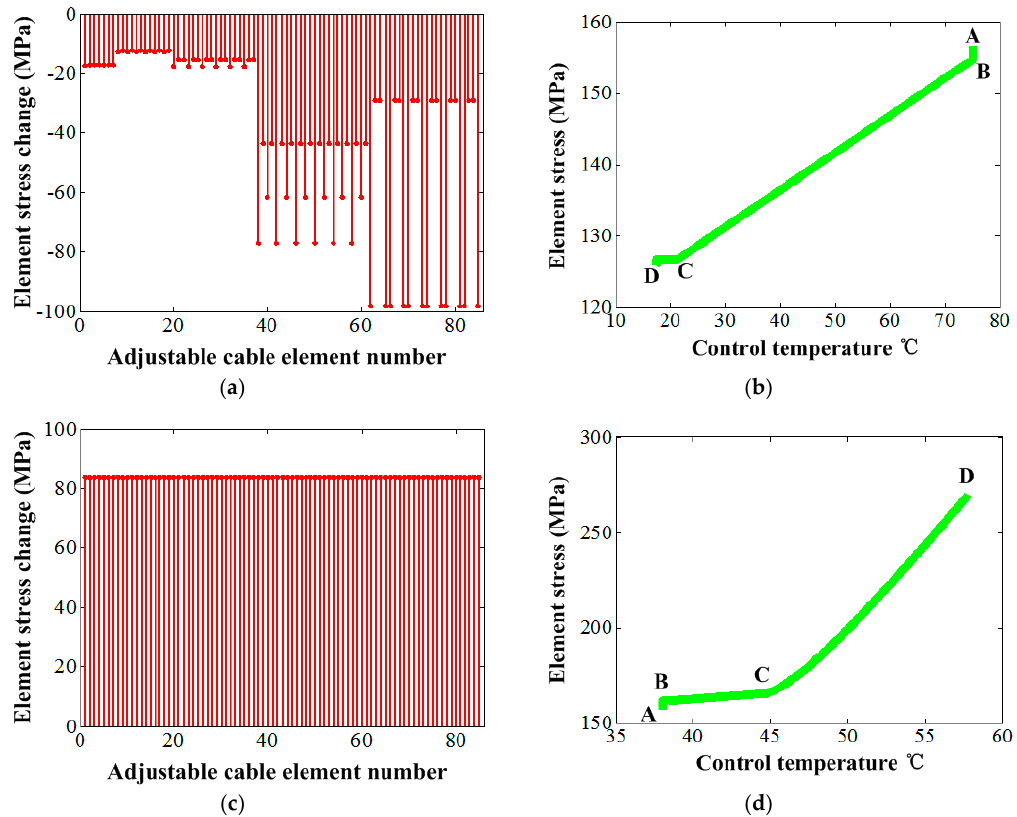
Figure 8. The element stress change under the control temperature: ( a ) Variations of all elements of vertical cables under environment temperature 140 °C, ( b ) single element change under environment temperature 140 °C, ( c ) variations of all elements of vertical cables under environment temperature − 100 °C and ( d ) single element change under environment temperature − 100 °C.